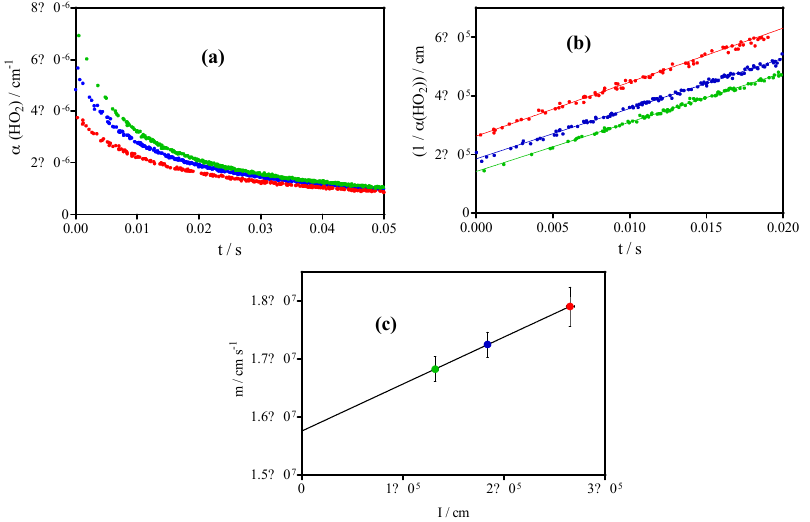
Figure 2. Example of measurement of HO 2 absorption cross-section using the kinetic method: graph ( a ) shows kinetic decays for 3 different Cl-atom concentrations, graph ( b ) shows the same signals plotted following Equation (3) with the linear regression over the first 20 ms, graph ( c ) shows the plot of slope m as a function of I , obtained in graph ( b ) for the 3